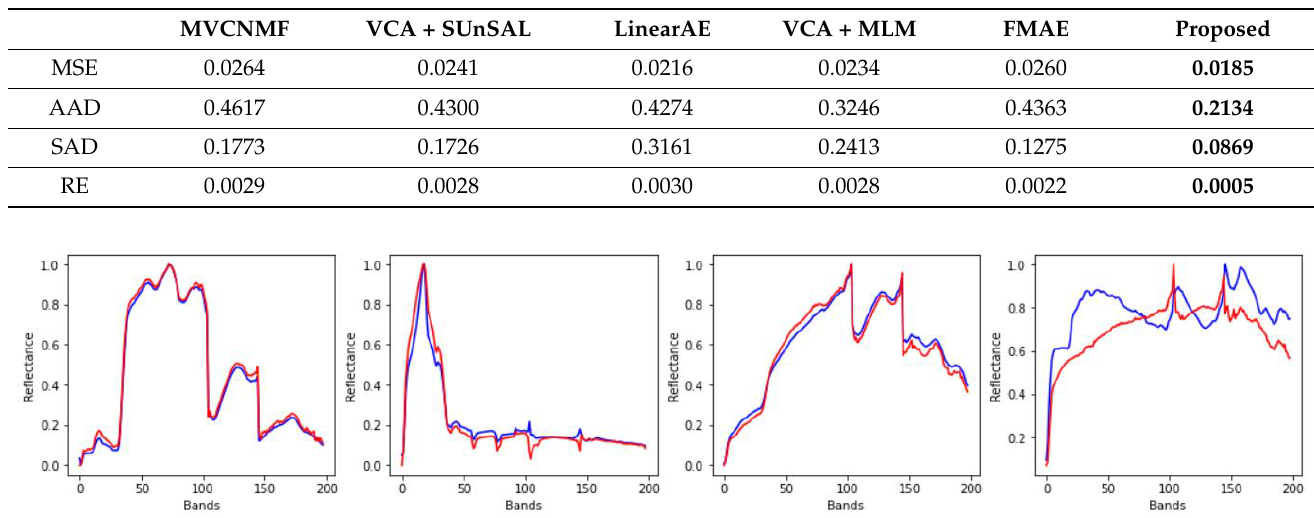
Figure 8. Comparison of the reference endmember (red line) with the endmember extracted by GBM_AE (blue line) on Jasper Ridge. From left to right for different endmembers: tree, water, soil and road.